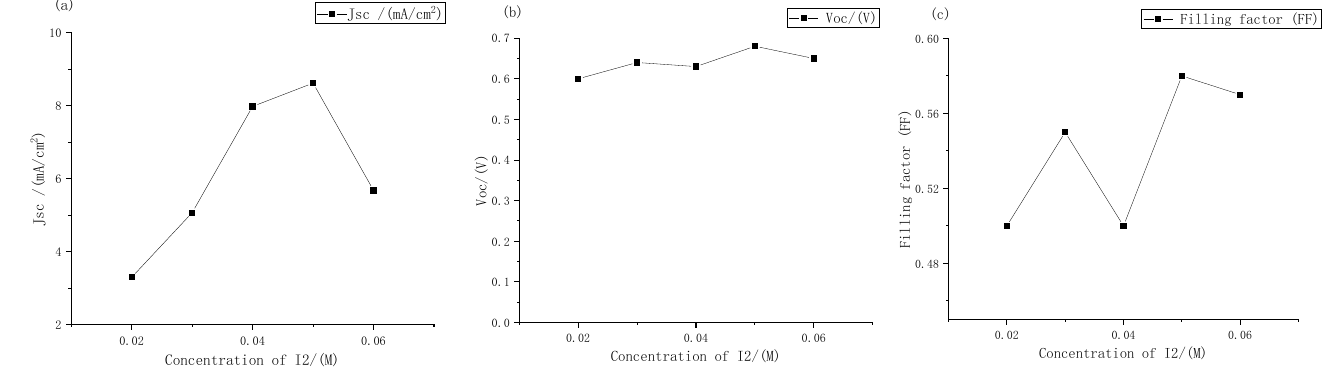
Figure 5. Performance changes in the external photoanode structure DSSC with different concen- trations of iodine under large gradient: ( a ) short circuit current density; ( b ) open circuit voltage; ( c ) filling factor.